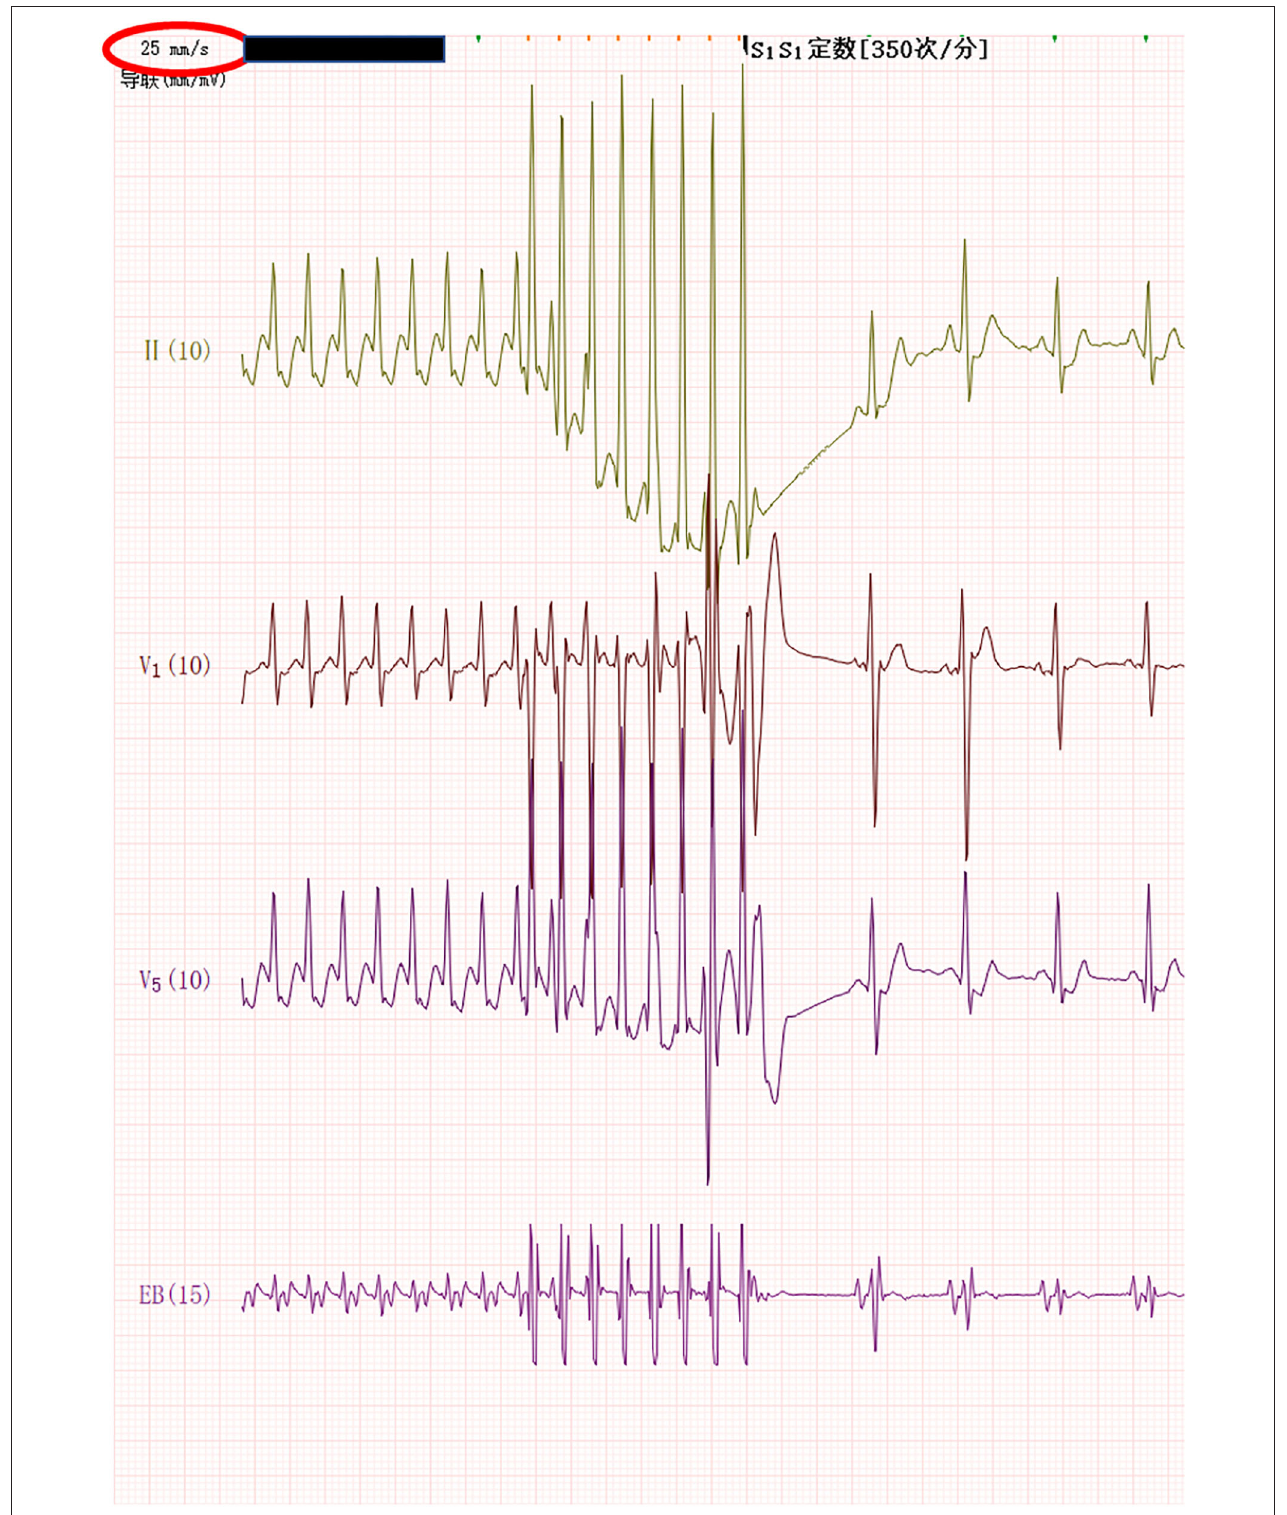
FIGURE 3 | The tachycardia stopped abruptly after the atrium was captured by eight overdrive stimuli with a frequency of 350 bpm.